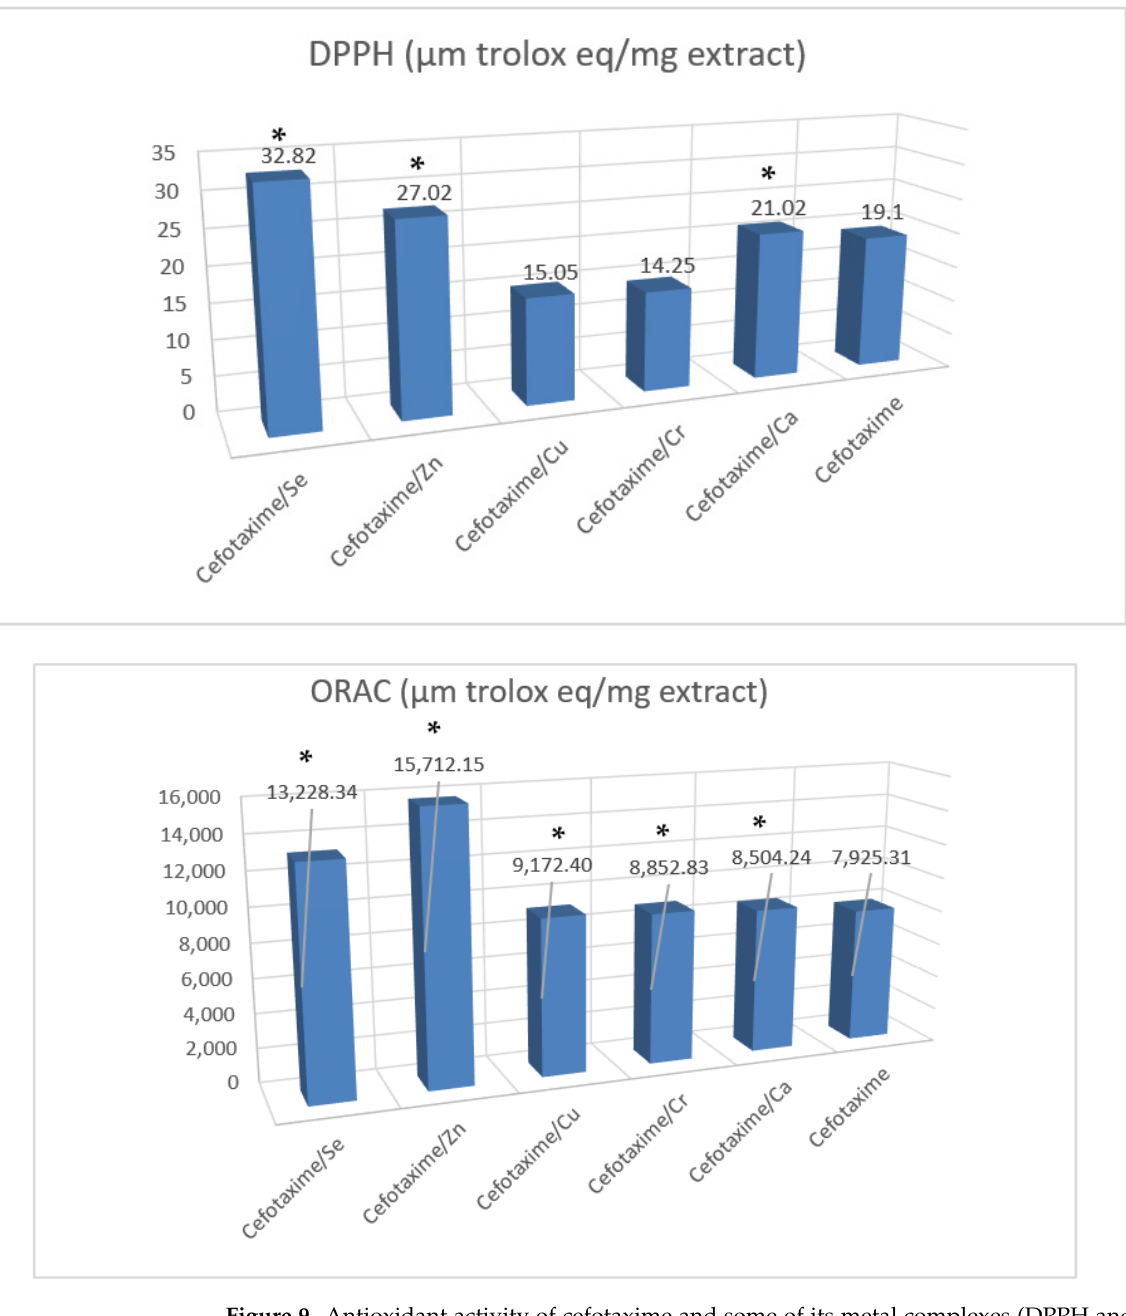
Figure 9. Antioxidant activity of cefotaxime and some of its metal complexes (DPPH and ORAC assays). Results are expressed as mean ± SE. (*) p ≤ 0.05 vs. cefotax group. Superscript * letters show significant differences ( p < 0.05) between cefotaxime metal complexes’ activities. Trolox eq means Trolox equivalents and SD means standard deviation.